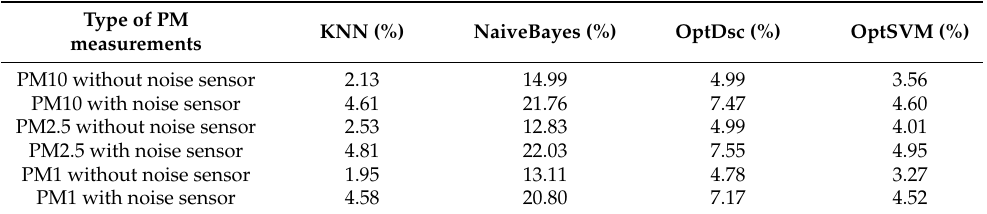
Table 7. Increase in Accuracy for learning DL networks over classical neural networks for different data